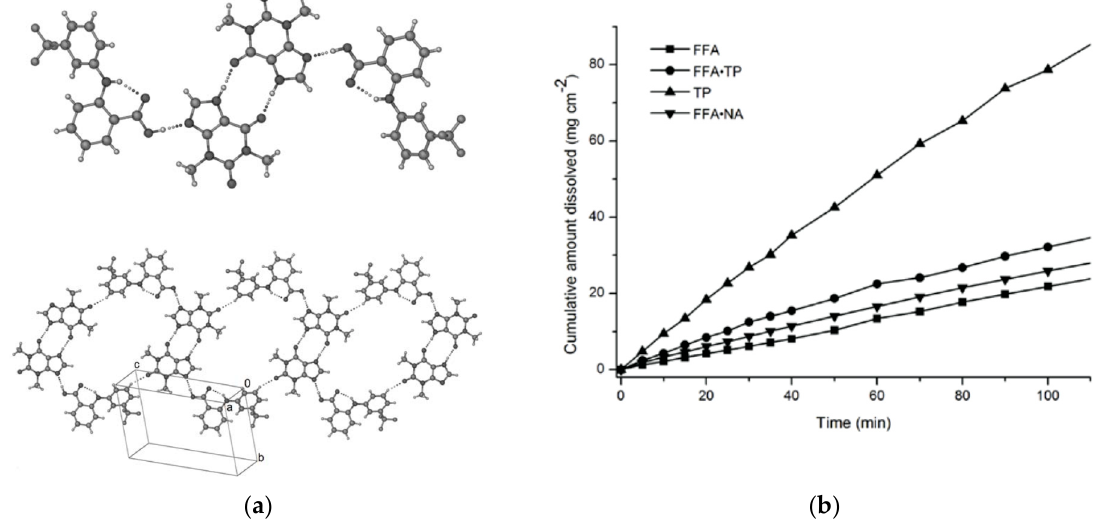
Figure 24. ( a ) Hydrogen bond interaction present in the 1:1 FFA-theophylline cocrystal. ( b ) Intrinsic dissolution rate of FFA and theophylline cocrystals with theophylline and nicotinamide respectively. Adapted with permission from CrystEngComm , 2014, 16 , 5793–5801. Copyright 2014, The Royal Society of Chemistry.